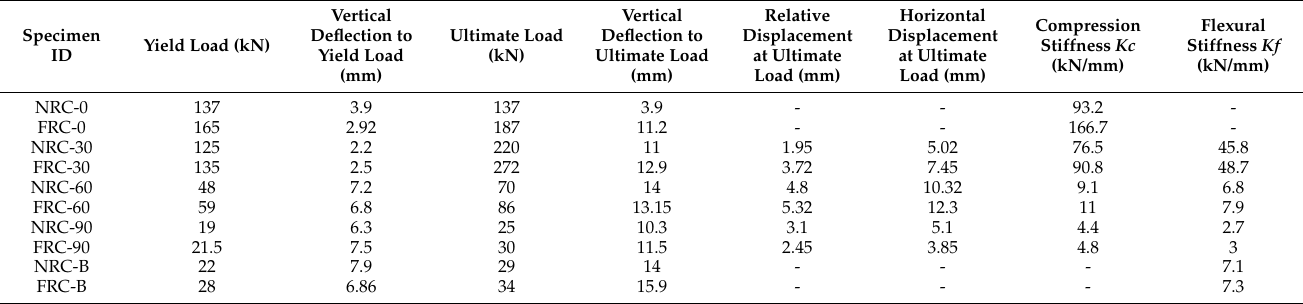
Table 9. Summary of compressive strength, ductility, and stiffness for all